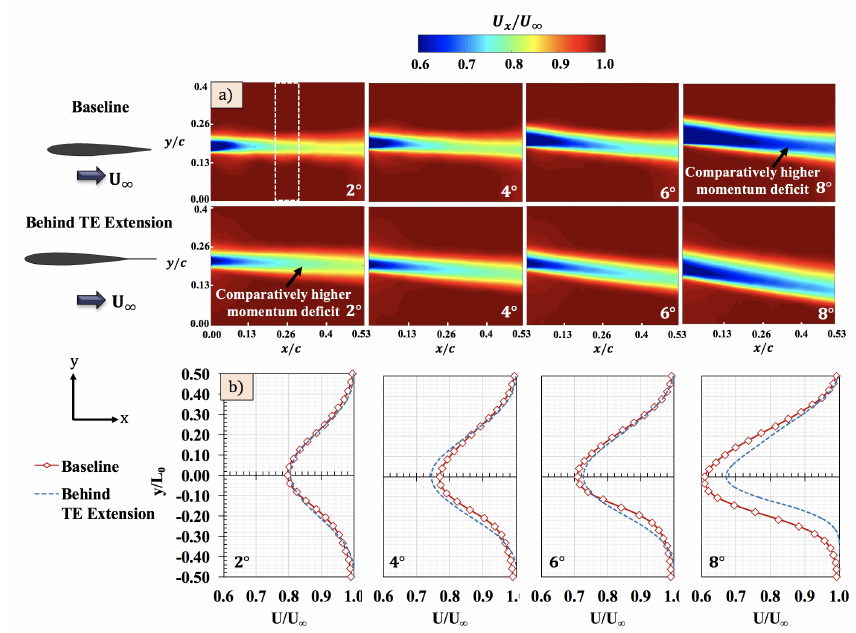
Figure 11. ( a ) Streamwise velocity contours in FSL behind the trailing edge of the NACA 0012 wing and behind the TE extension ( b ) Momentum deficit profiles at different angles of attack for both cases. The momentum deficit behind the TE extension is lower at higher angles of attack when compared to the baseline.